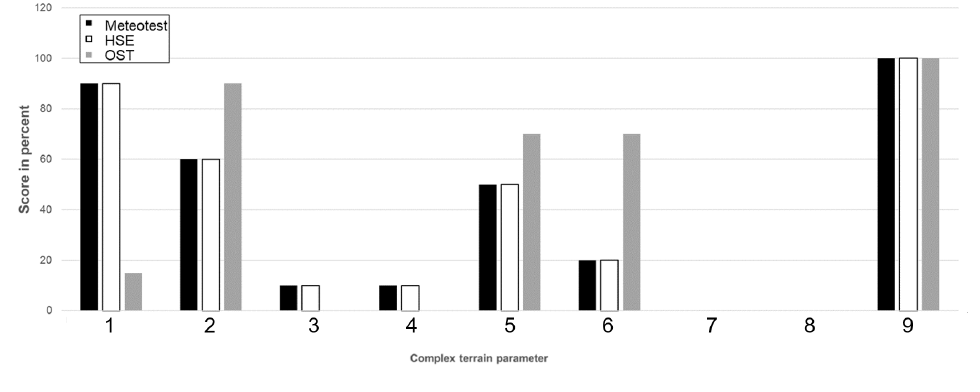
Figure A5. Answers to the ten complex terrain questions for Site 2.